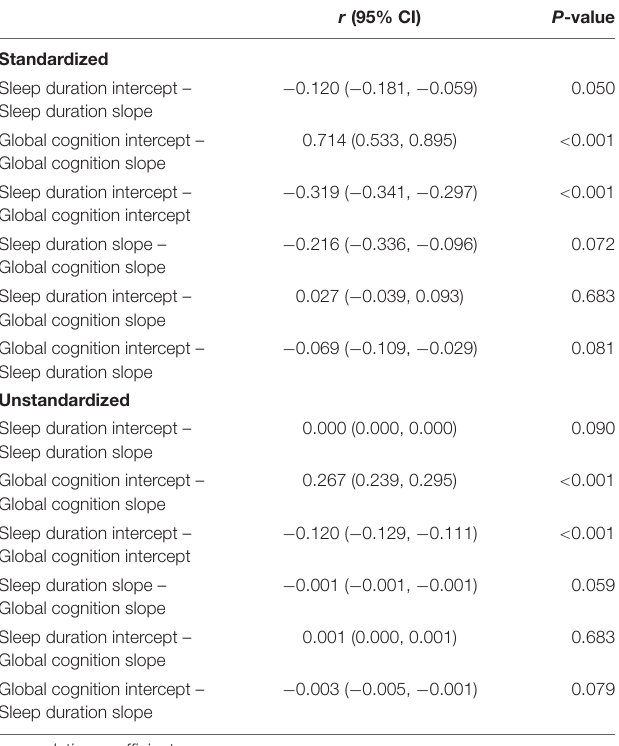
TABLE 2 | Correlations between the trajectories using the combined latent growth